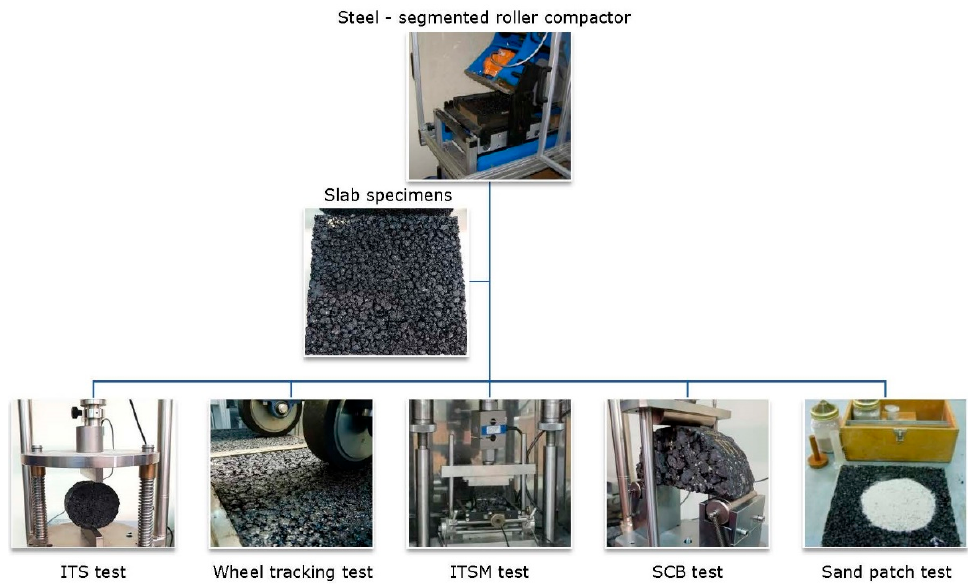
Figure 2. Experimental plan.